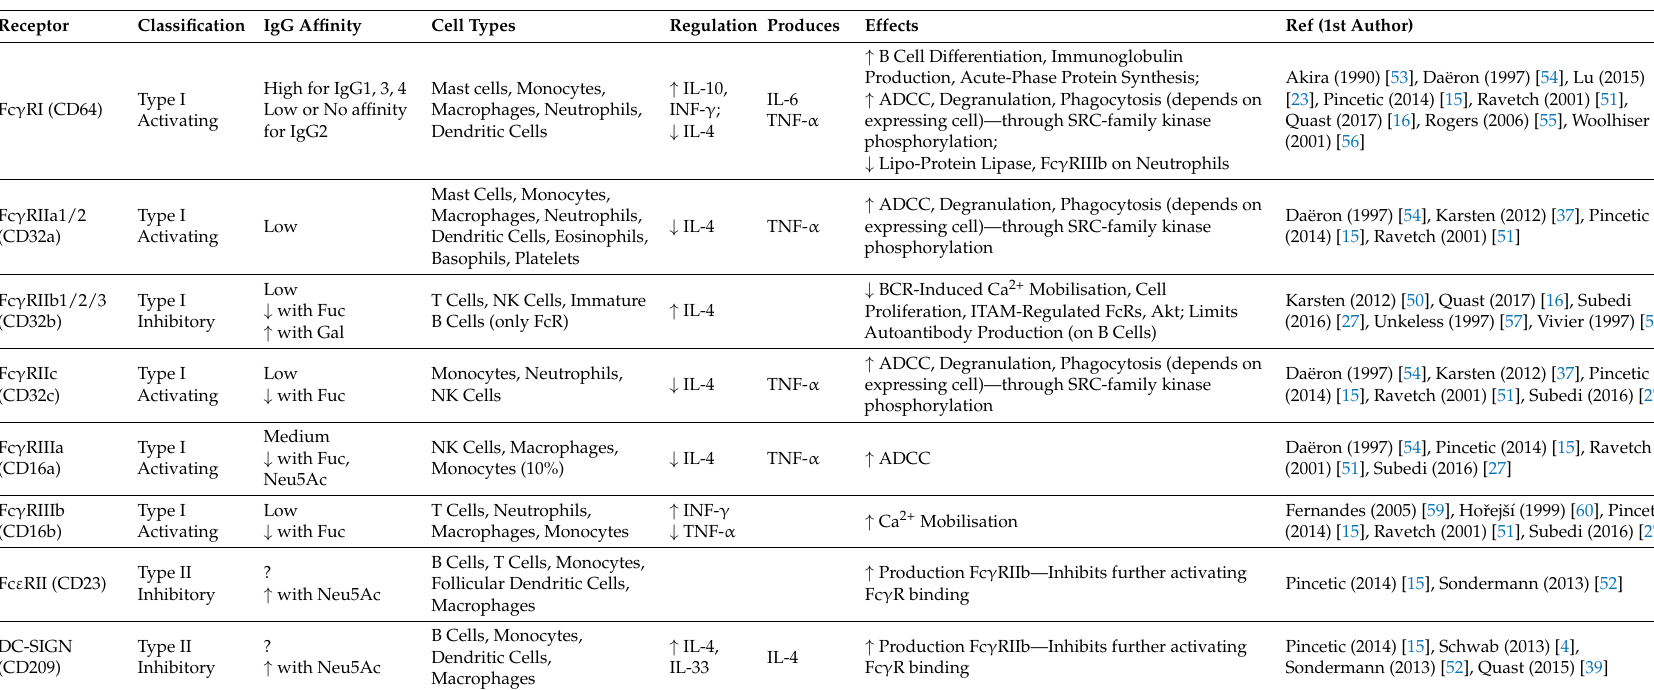
Table 1. Summary of fragment crystallisable receptors (FcRs) ligated by IgG. Regulation: either up- or down-regulation of the expression of the FcR on a given cell. Produces: the cytokines released following binding with the given FcR. Effects: summary points from the